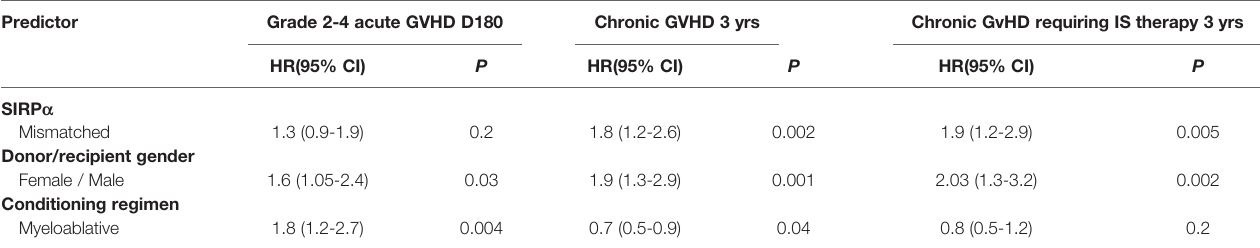
TABLE 3 | Multivariable analysis evaluating predictors of grade 2-4 acute GVHD, chronic GVHD and chronic GVHD requiring immunosuppressive therapy